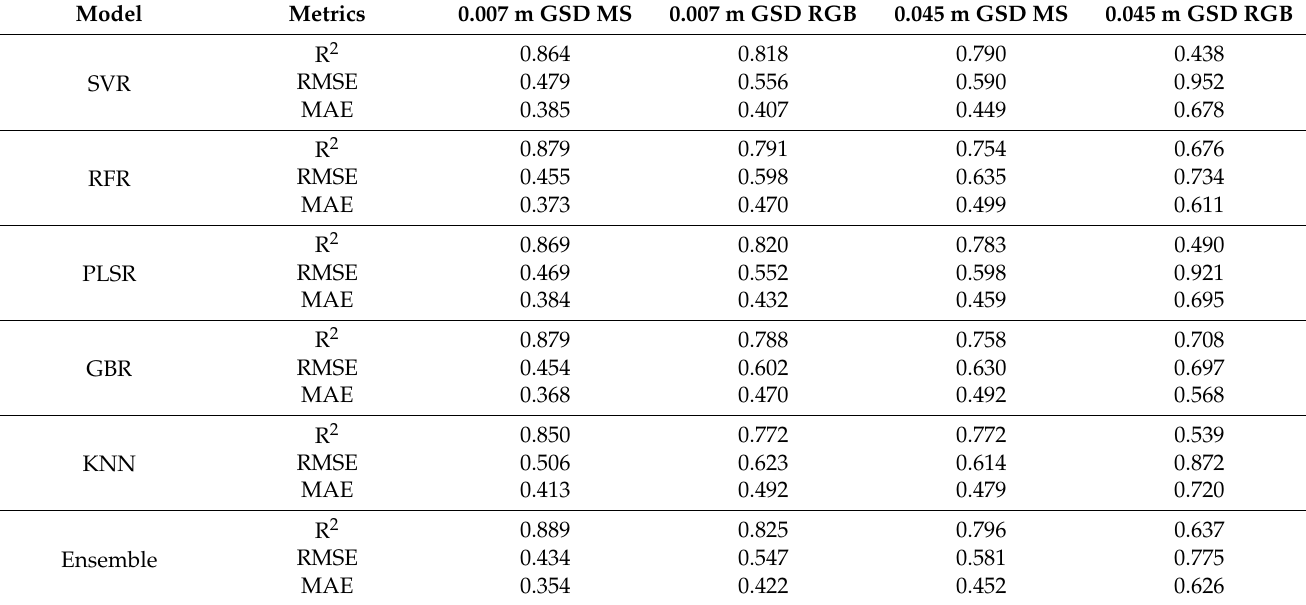
Table 6. Performances of base and ensemble models in LAI prediction under different GSD and sensor